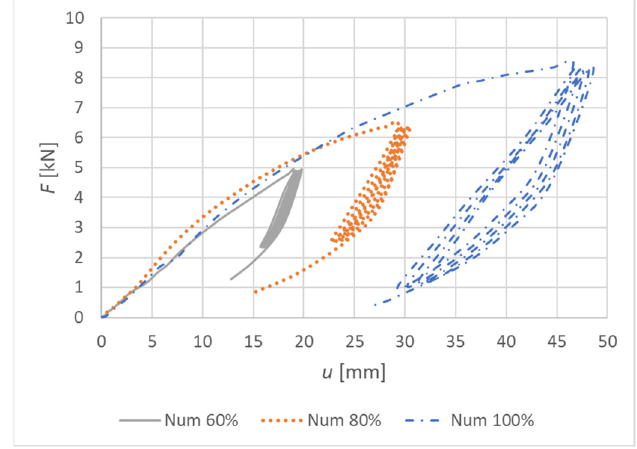
Figure 22. Load–deformation curves of quasi-static numerical modeling for individual specimens made from a combination of bolts and dowels (Experiment A).